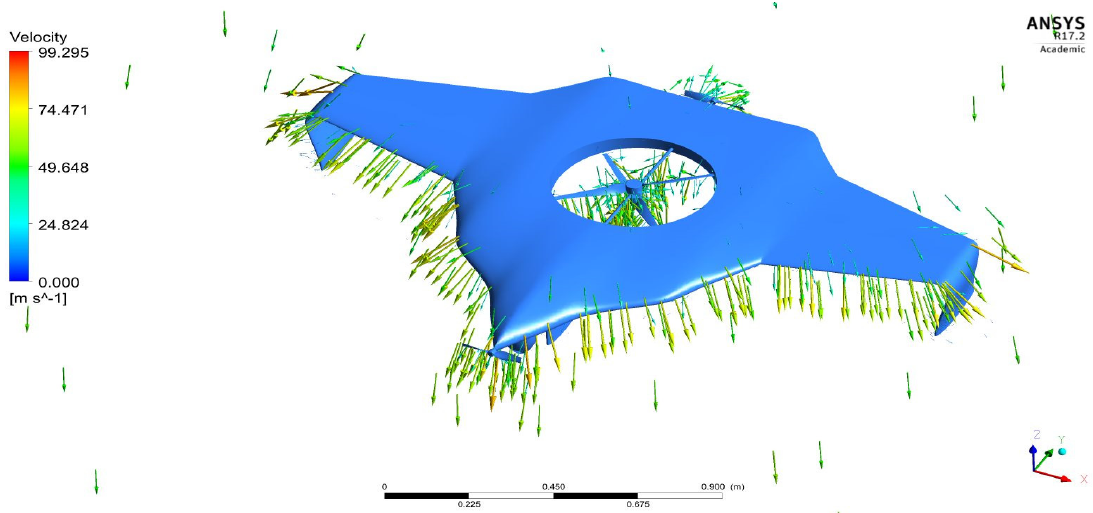
Figure 10. Velocity variations on UAV under VTOL.